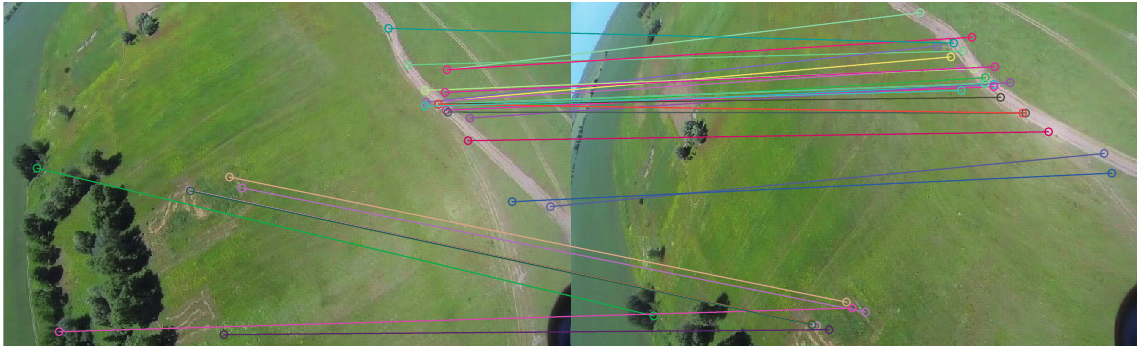
Fig. 5. The matching of two video frames from aboard a UAS with a difference of 40 frames (1.6 sec, 25 fps) with the correlation threshold K = 0.95. The number of false matching is 4 from a total of 31 matching features. The average time for computing the matches is 0.0039